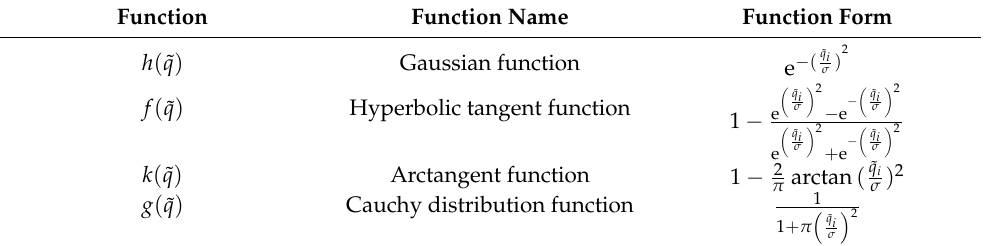
Table 1. The forms of cooperative control